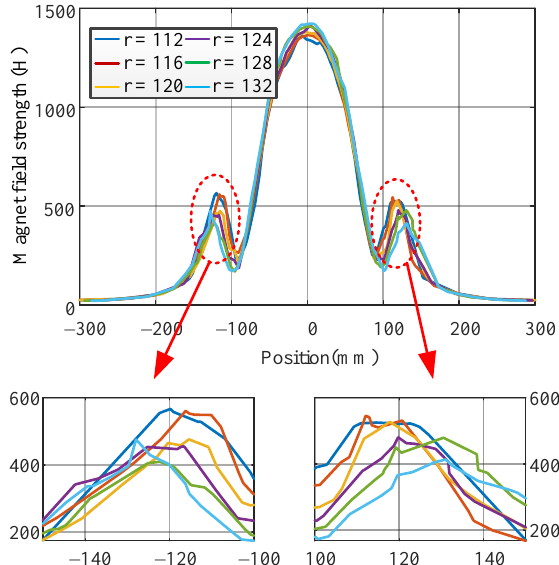
Figure 8. Magnetic field strength curves of shields with different radius.